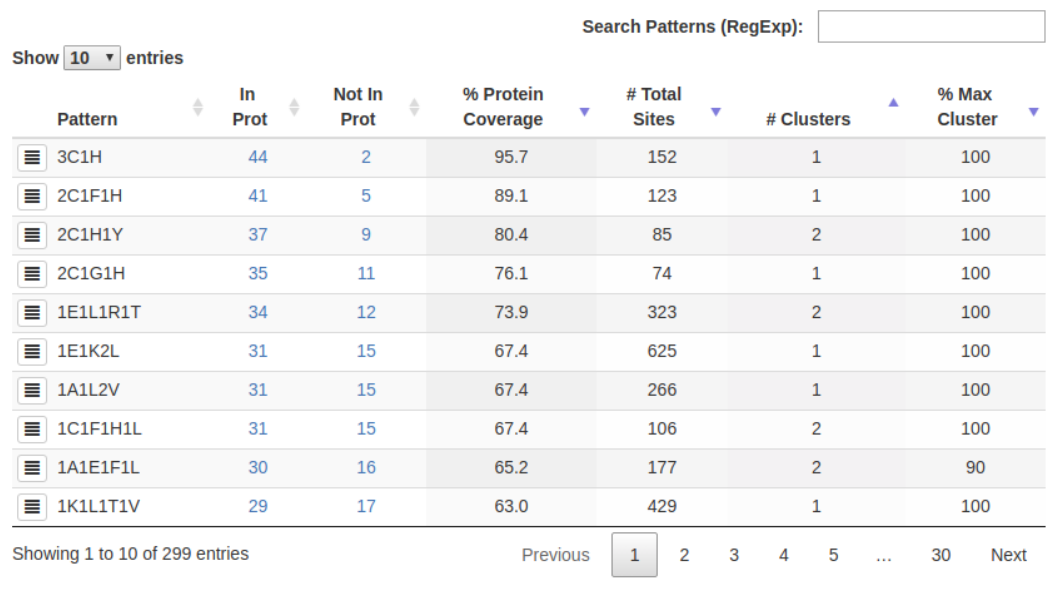
Figure 1. Coverage of 3D-patterns identified in the Zinc finger C3H1-type protein structures. Figure 1 shows the list of all 3D-patterns detected and several criteria for